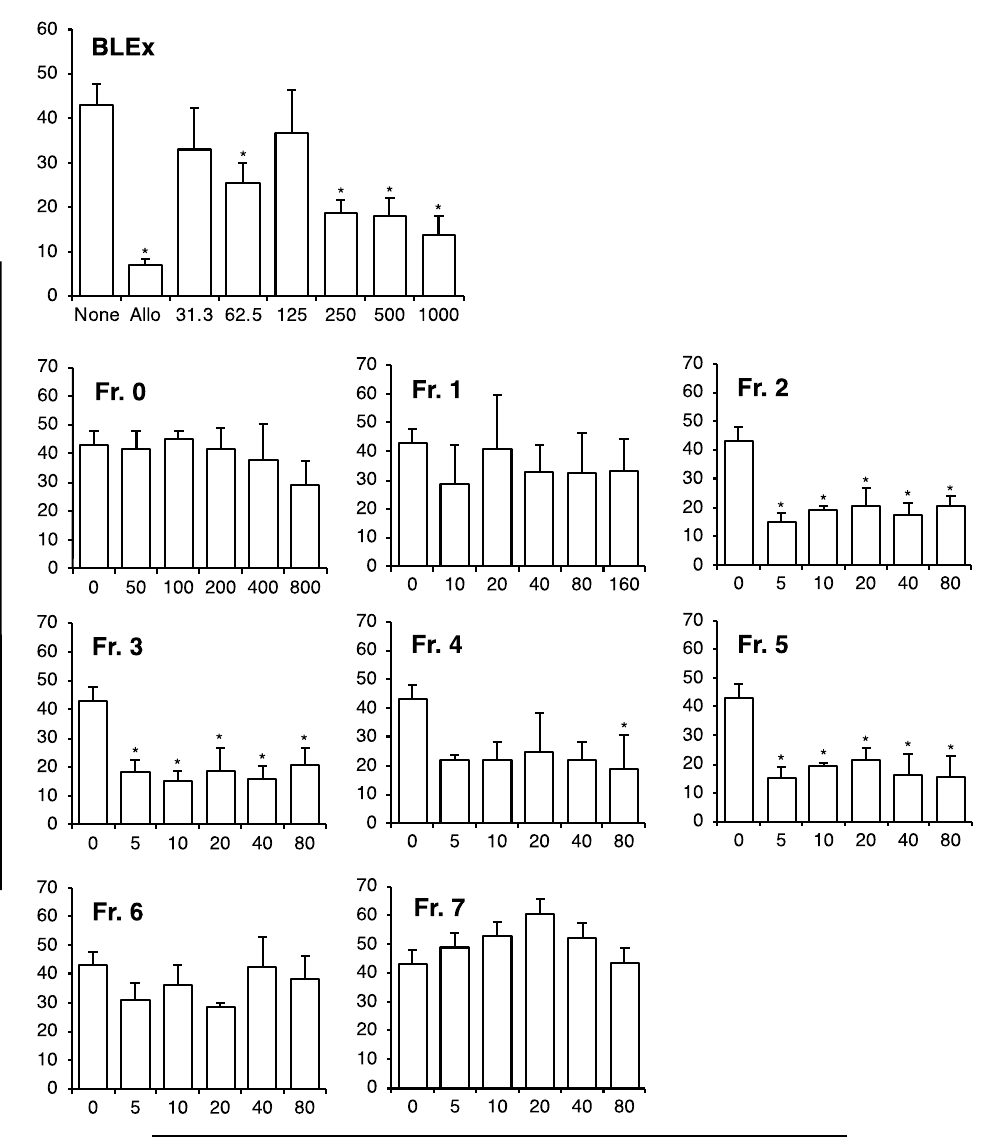
Figure 8. Direct effect of BLEx and its fractionated samples on XOD activity. Data are means ± SE for 3 independent experiments. Statistical analysis was performed using one-way analysis of variance (ANOVA) and post hoc tests (Tukey– Kramer multiple comparisons). Asterisks indicate significant differences compared to the control at p < 0.05. XOD activity was evaluated by the conversion of xanthine into uric acid with or without BLEx or its fractionated samples at the indicated concentrations. As the positive control, inhibition of XOD activity by allopurinol (1 mM) is shown in the panel of BLEx.